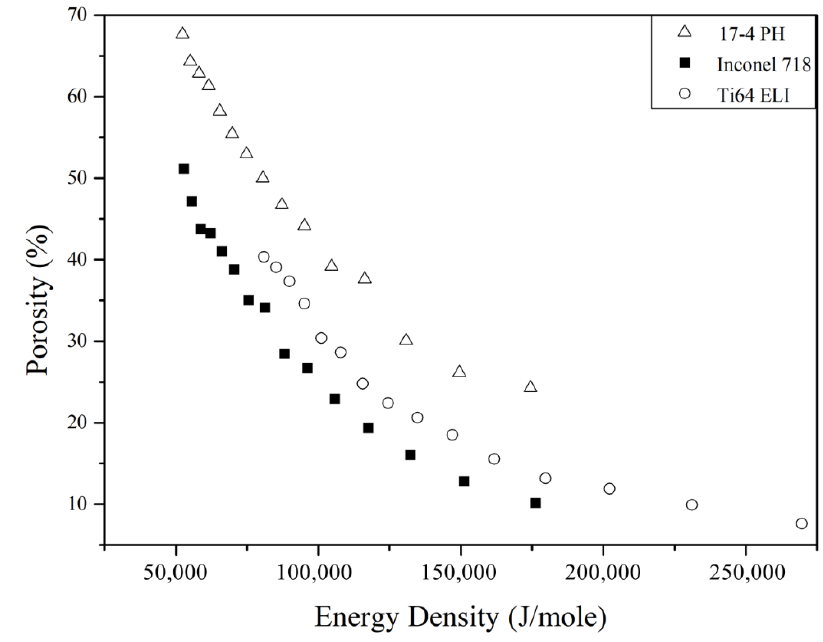
Figure 4. Relation between porosity and molar energy density ( ED mole ) of the three alloys.